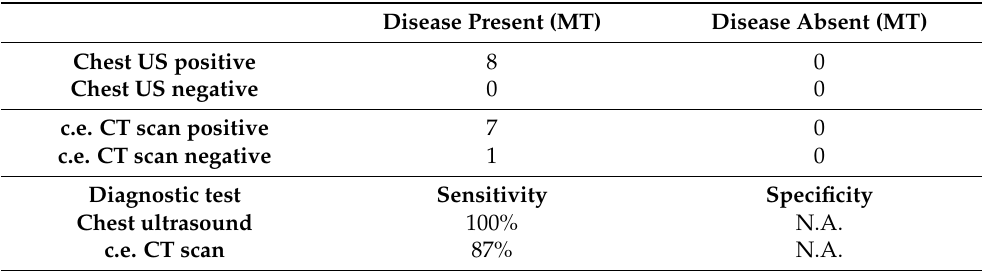
Table 7. Subgroup of 8 cases with contrast enhanced (c.e.) CT scan of the chest. Chest US and CT scan compared with MT gold standard for pleural abnormalities in CPA.